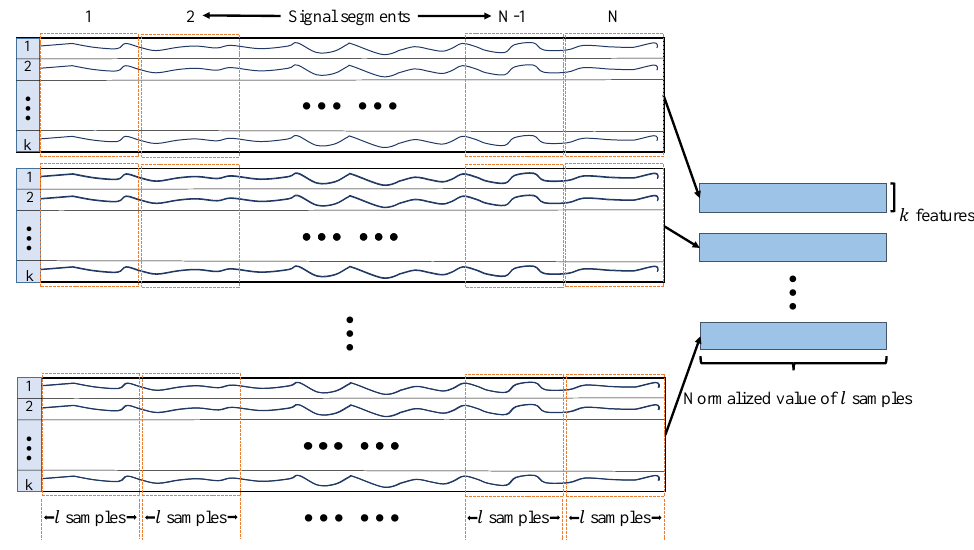
Figure 8. Proposed sensor data processing method.